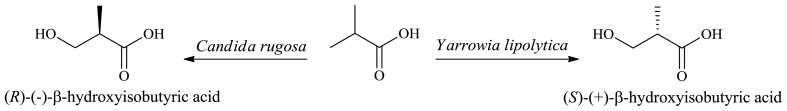
Enantioselective, microbiological hydroxylation of isobutyric acid.